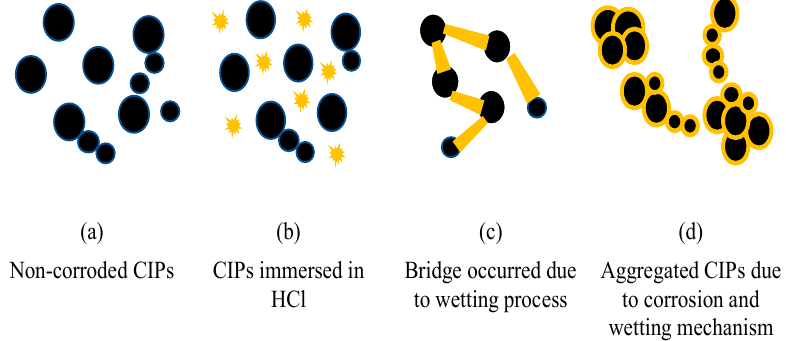
Figure 11. Mechanism of aggregated CIPs due to the corrosion process are illustrated in ( a ) Non-corroded CIPs, ( b ) CIPs immersed in HCl, ( c ) Bridge occurred due to wetting process and ( d ) Aggregated CIPs due to corrosion and wetting mechanism.